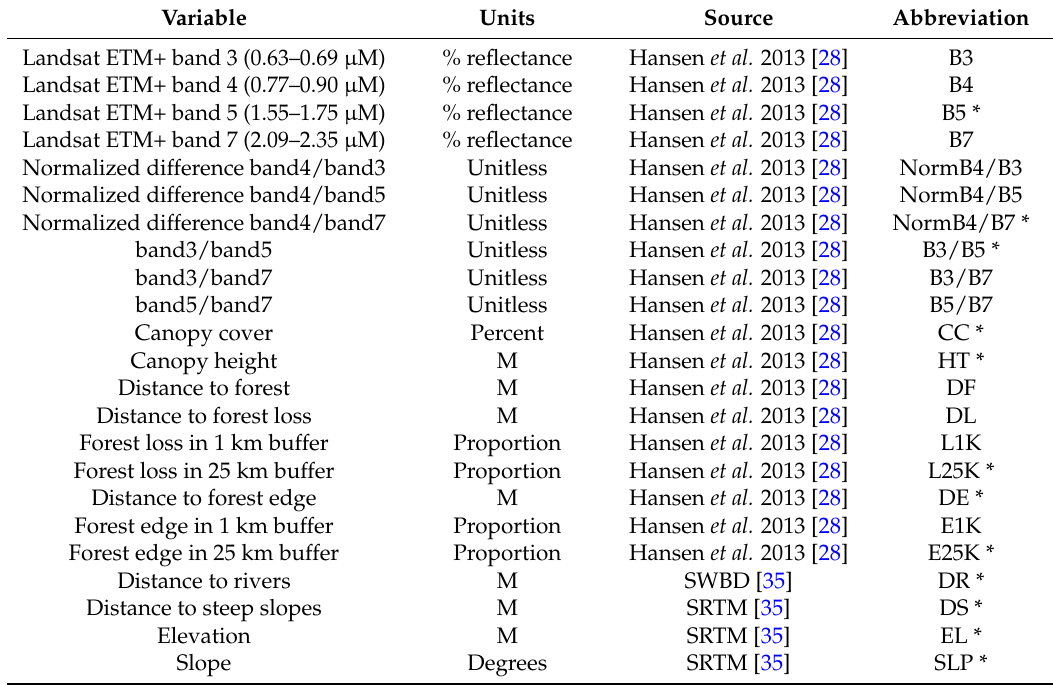
Table 1. List of predictor variables used as input to Random Forest regression models. Variable Units